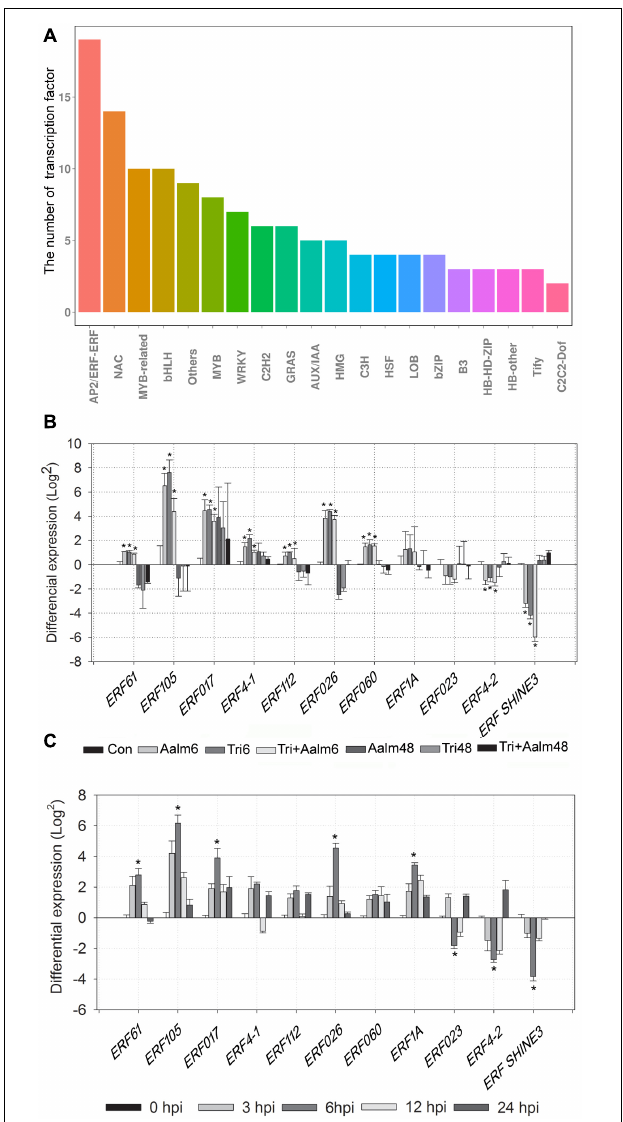
FIGURE 4 | Differential expression of 11 genes of ERF transcription factor family. (A) The number of differentially expressed transcription factors from different families, after M. sieversii treated with Trichoderma biofertilizer for 6 h. (B) Differential expression of ERF transcription factor family genes, the data were counted from M. sieversii transcriptome data. (C) Differential expression of ERF transcription factor family genes, after M. sieversii treated with Trichoderma biofertilizer, the data were counted by RT-qPCR, ANOVA was conducted using Duncan’s method, and p ≤ 0.05 was considered significant. RT-qPCR: quantitative real-time